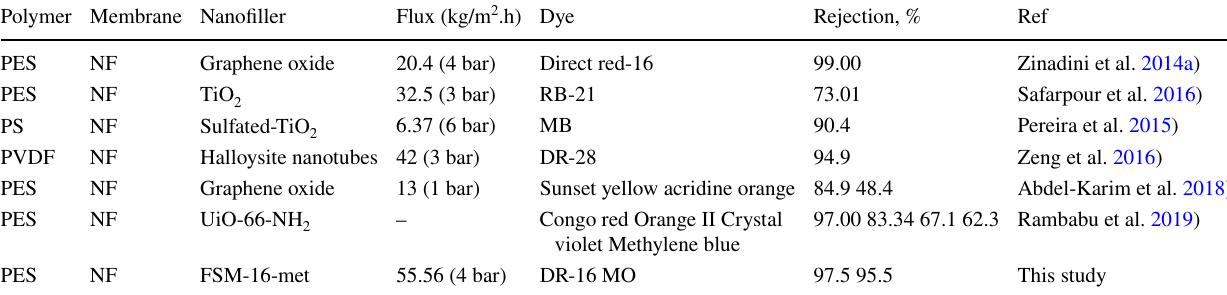
Table 5 A comparison study on the performance of different membranes in dye rejection Polymer Membrane